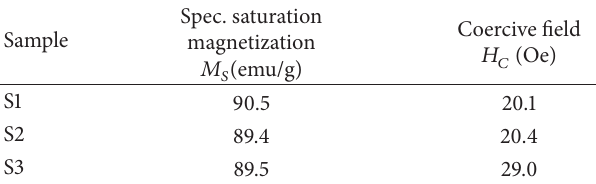
Table 3: Static magnetic properties of the sintered